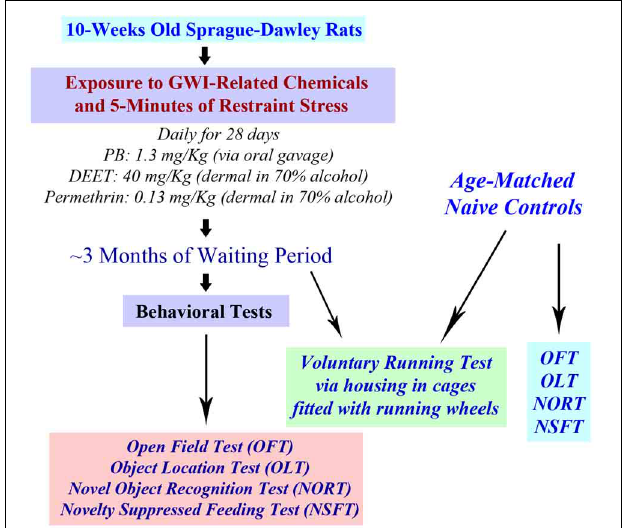
FIGURE 1 | A schematic showing the time-line of various experiments. Rats were first exposed daily to Gulf War illness related (GWIR) chemicals and 5-min of restraint stress for 28 days. After a waiting period of ∼ 3 months, a larger cohort of rats was subjected to behavioral tests in the following order: open field test (OFT), object location test (OLT), novel object recognition test (NORT), and novelty suppressed feeding test (NSFT). Another cohort of rats underwent a voluntary running test through housing in cages fitted with running wheels for 4 weeks. Cohorts of age-matched naive rats were also examined using all of these behavioral tests for comparison of